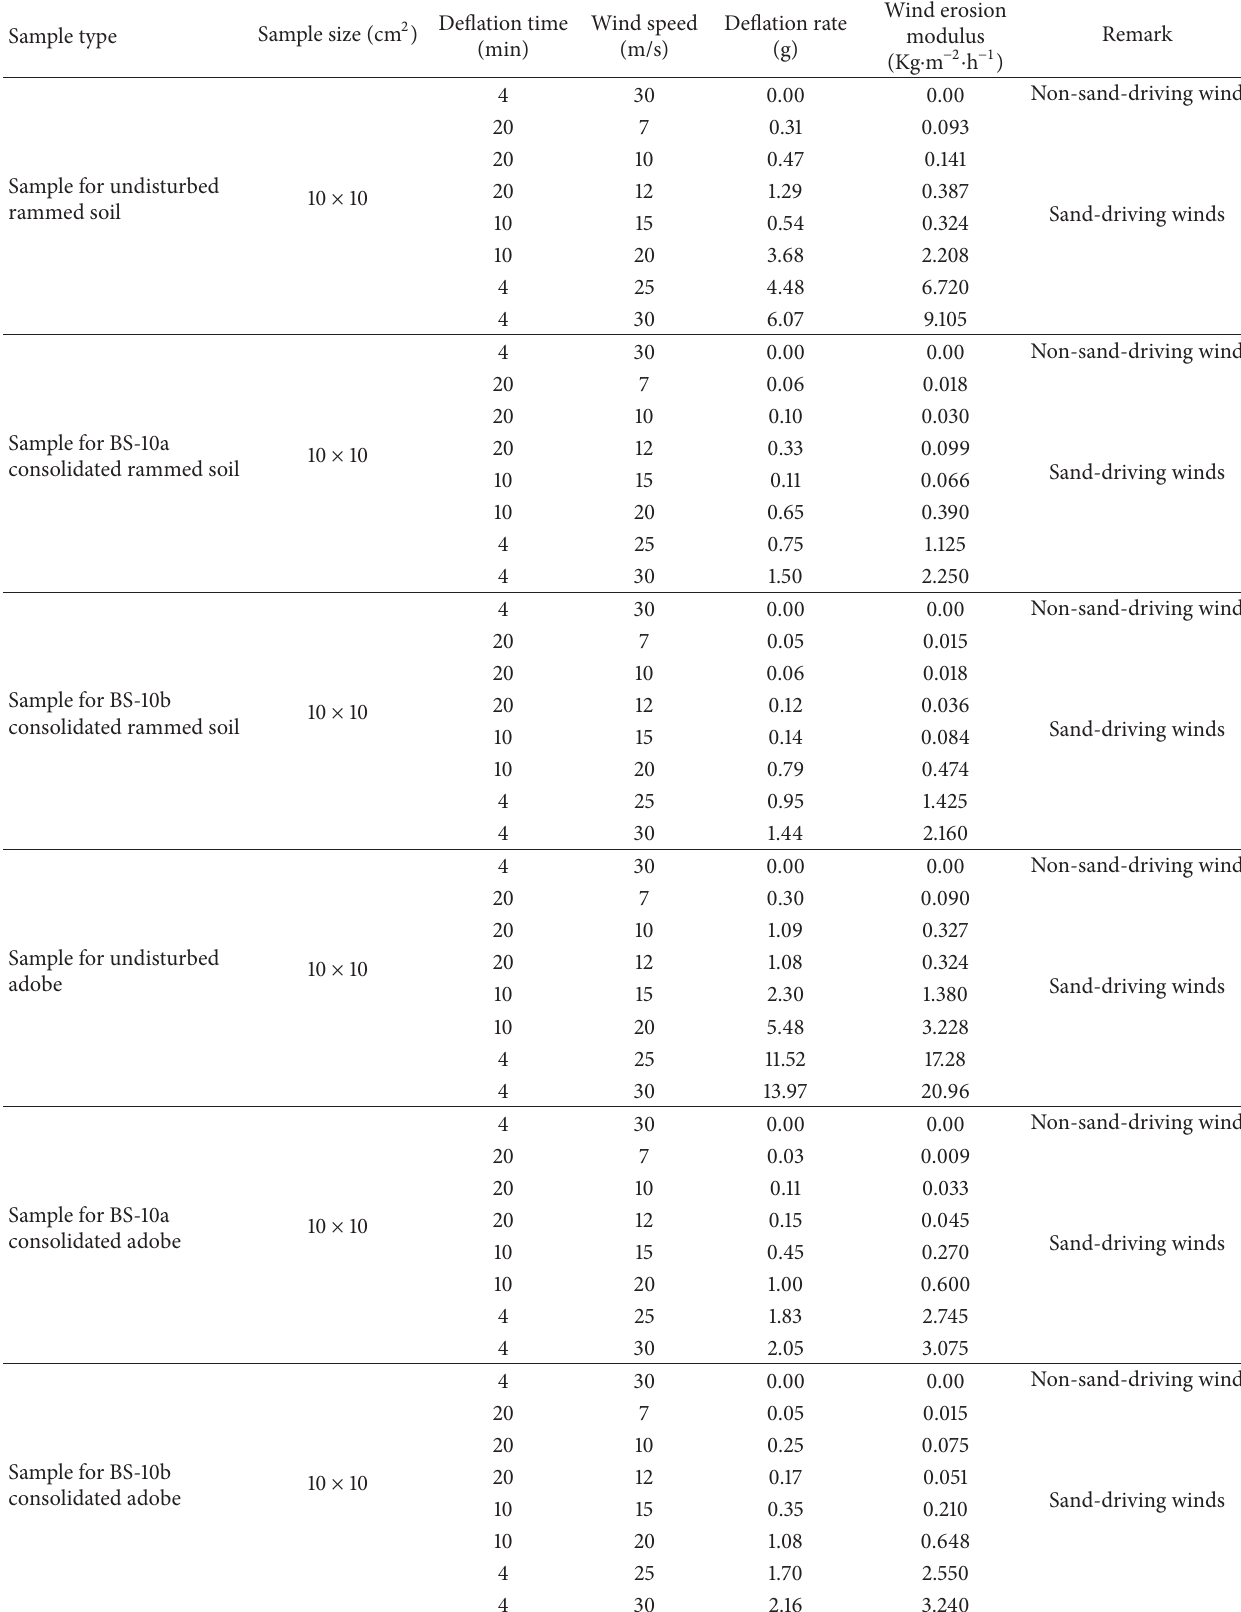
Table 7: Comparison of wind erosion amount before and after the